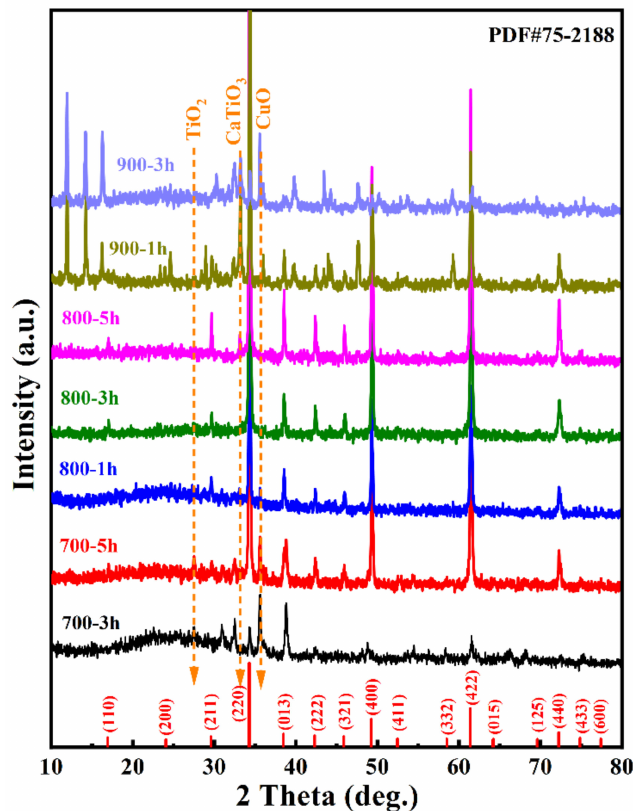
Figure 2. XRD patterns of CCTO powders calcinated at different conditions. Red vertical lines represent the standard pattern of CCTO (JCPDS